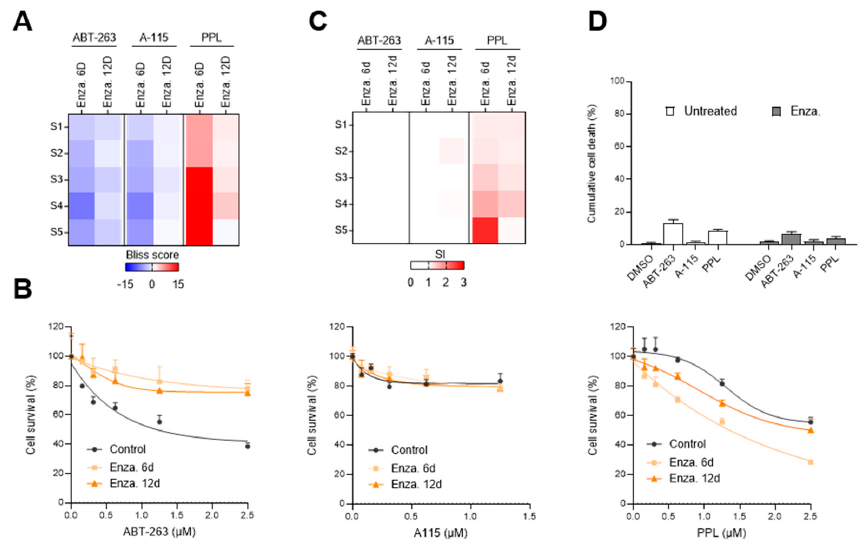
Figure 5. Enza-TIS cells are not sensitive to senolytics. ( A – D ) LNCaP expressing H2B-GFP were treated with 10 µM enzalutamide (Enza) for 6 or 12 days, alone or in combination with increasing concentrations of ABT-263 (left), A-1155463 (A-115, middle) or PPL (right). ( A , C ) Heat maps of bliss scores ( A ) and senolytic indexes (SI) ( C ) for LNCaP treated with the indicated combination treatments. S1 to S5 correspond to increasing senolytic concentrations (see Figure S3A). ( B ) Cell survival curves of LNCaP expressing H2B-GFP and treated with the indicated combination treatments. ( D ) The cumulative cell death of LNCaP was analyzed by flow cytometry 6 days after 10 µM Enza exposure, alone or in combination with 0.625 µM ABT-263, 0.3125 µM A-115 or 0.625 µM PPL ( A , C , D ). The mean ± SD of three independent experiments is shown. ( B ) Data are the mean ± SD of triplicate and are representatives of three independent experiments. Data were analyzed using the two-tailed Student’s t -test.